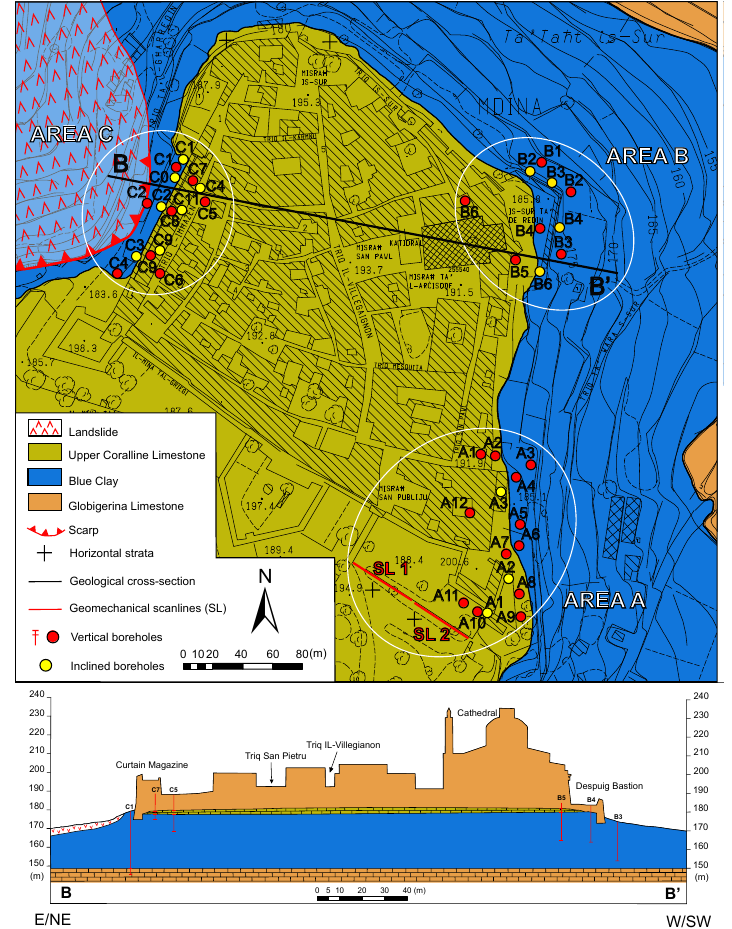
Fig. 6. Geological map and cross-section of Mdina. Area A: Vilhena Palace; Area B: Cathedral and Despuig Bastion; Area C: Curtain